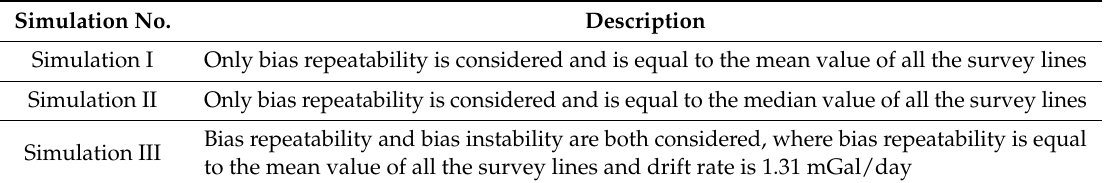
Table 3. Simulations on the survey lines.